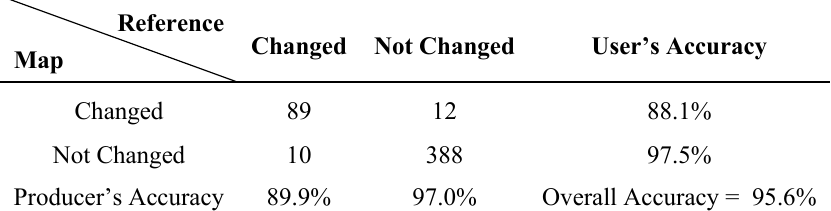
Table 6. Change detection error matrix, Neural Network